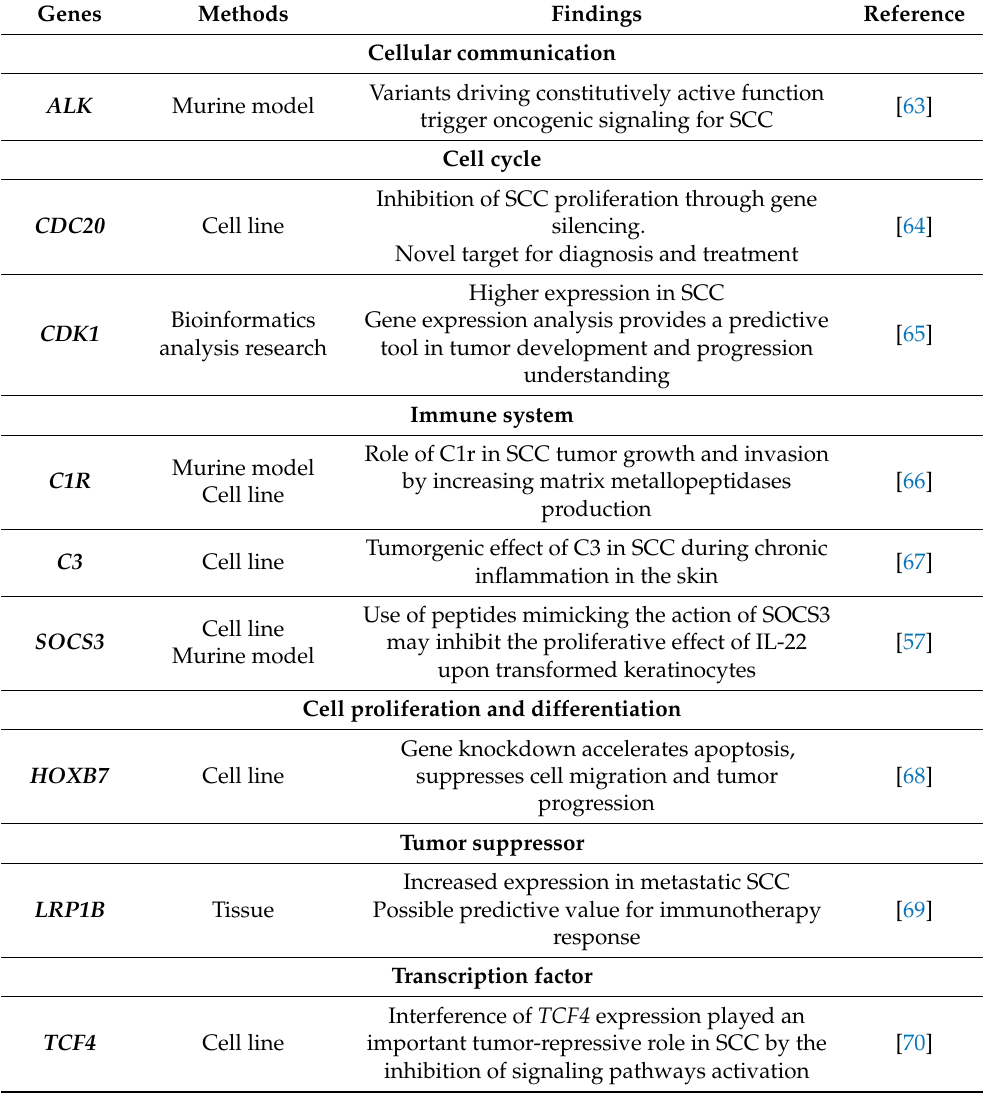
Table 2. Candidate genes for